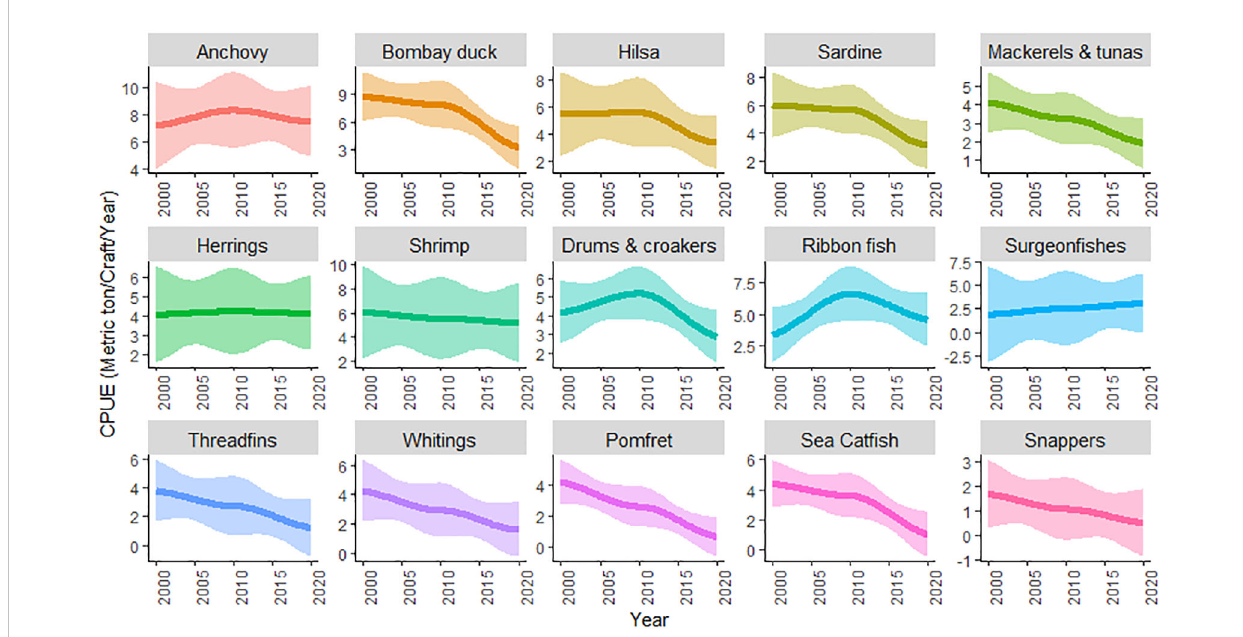
FIGURE 2 Trends of catch per unit effort (CPUE) of the major marine fi sh groups in the Bay of Bengal small-scale marine fi shery from 2000 to 2020. The solid line is the smooth function estimate and shaded regions represent 95% con fi dence interval (CI). Source: Fishers ’ FGD